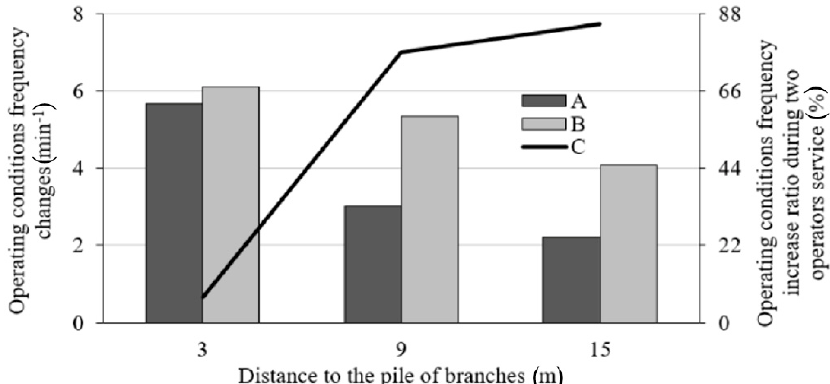
Figure 7. Frequency of cylindrical chipper operating condition changes depending on the number of operators and distance of the pile of branches to the chipper; A—for one operator, B—for two operators, C—increase of frequency of chipper operating condition changes due to increased number of operators to two.